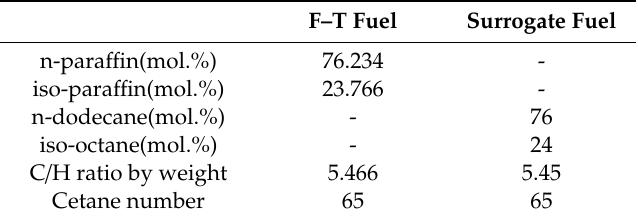
Table 1. Compositions and properties of Fischer–Tropsch (F–T) and surrogate